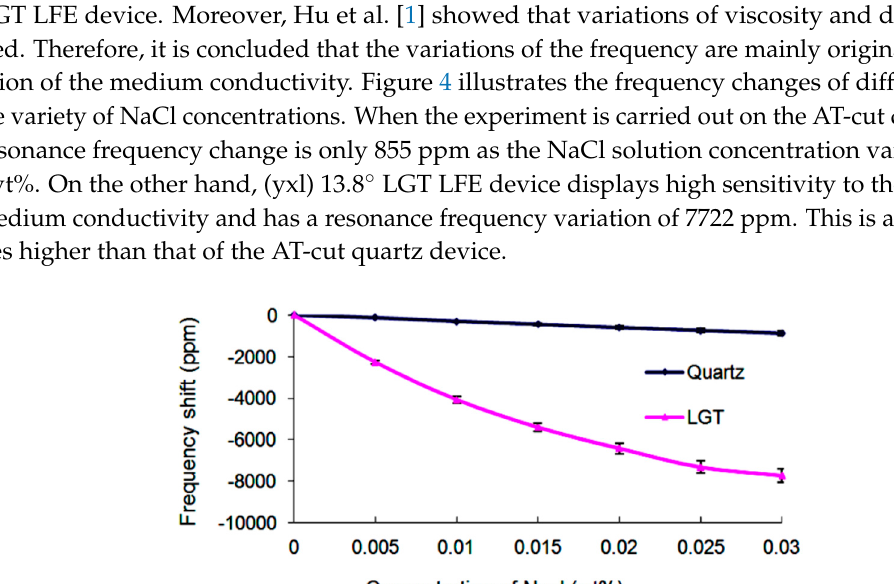
5 of 9 Figure 3. Impedance properties of the (yxl) 13.8° LGT LFE device in different mediums: ( a ) air ( b ) water. 4.2. Measurement of Sensing Characteristics